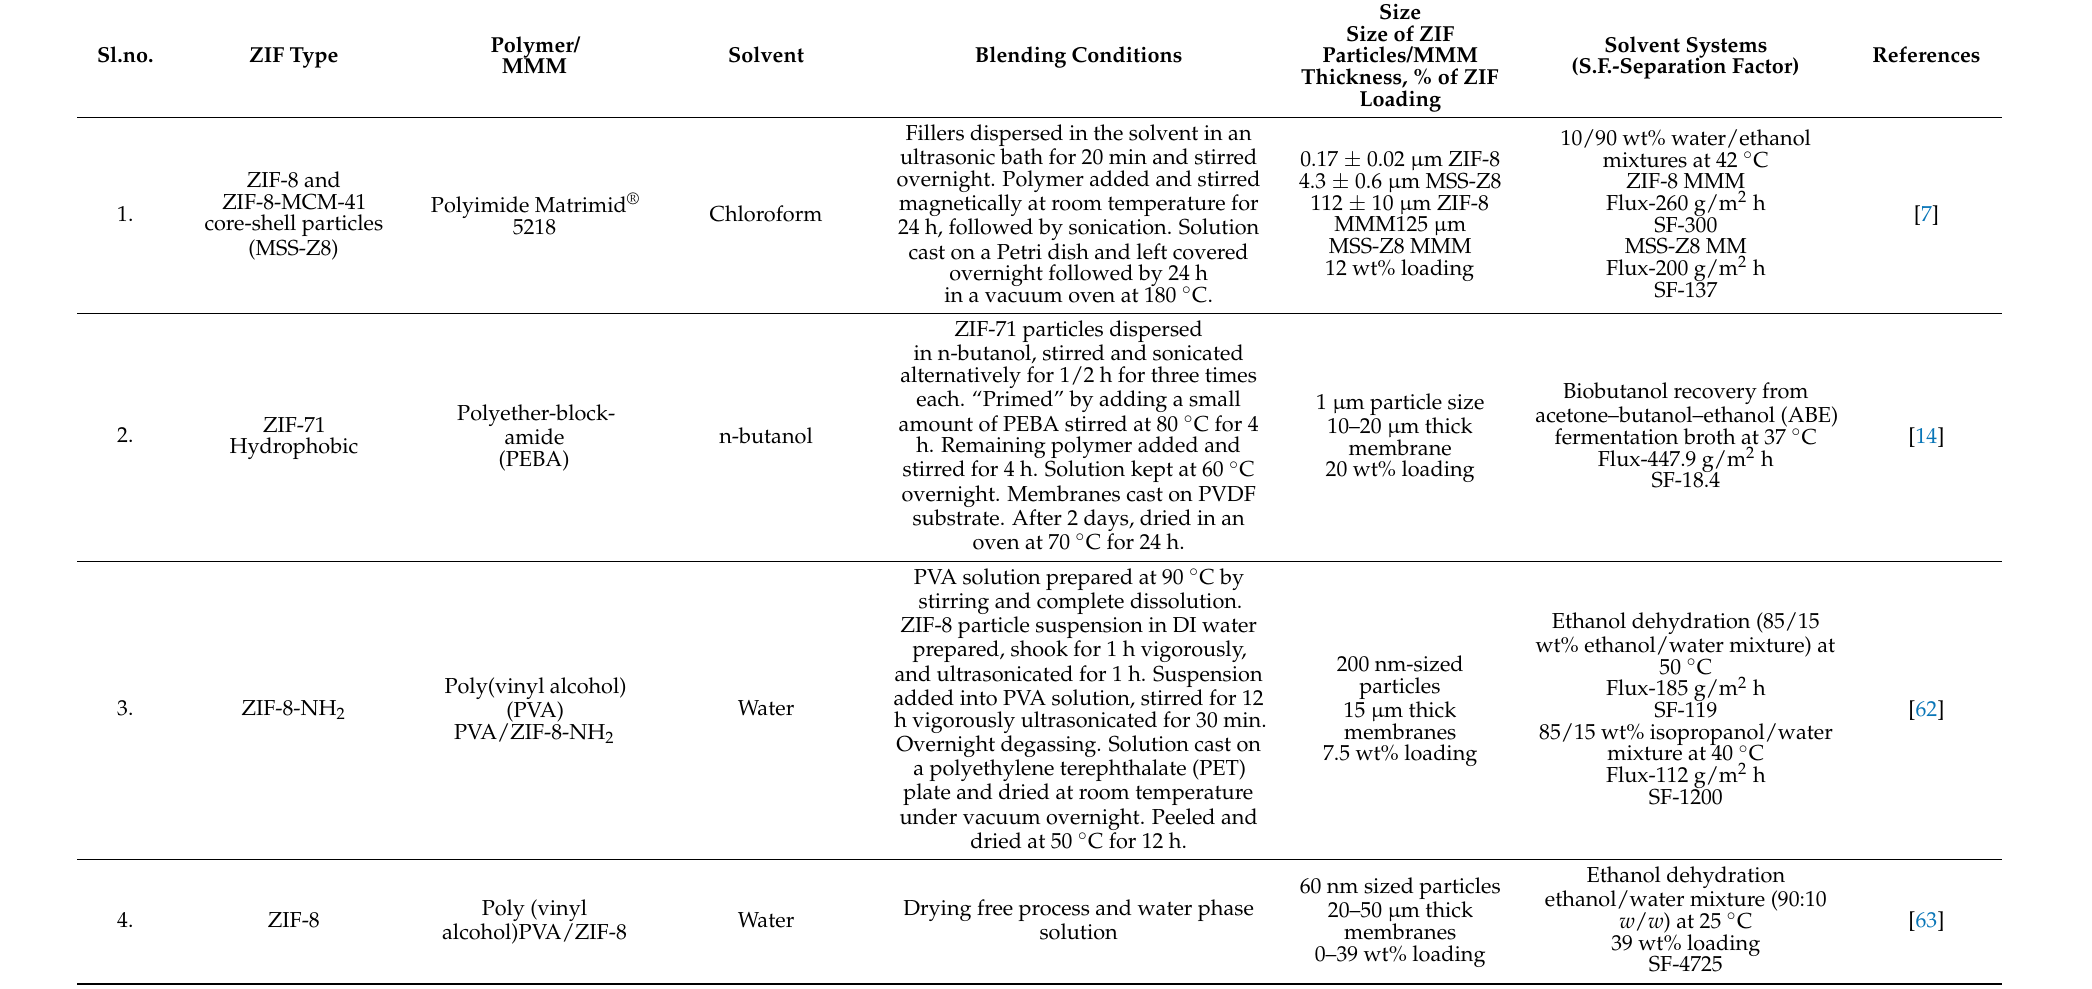
Table 2. ZIF-Polymer mixed matrix membranes’ blending conditions, membrane characteristics and separation performance.